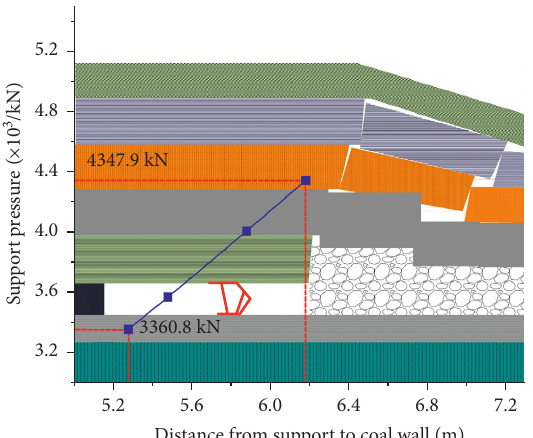
Figure 4: Curves of the working resistance of the bracket at dif- ferent positions.